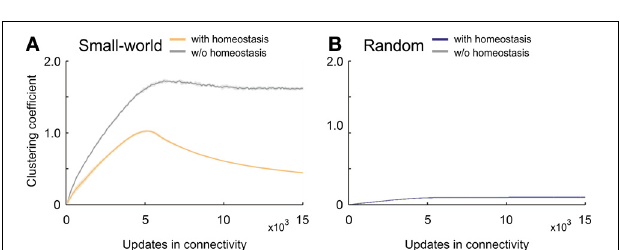
FIGURE 6 | Clustering coefficient in developing networks. (A) Small-world networks with (orange) and without (gray) homeostasis in electrical activity. (B) Random networks with (blue) and without (gray) homeostasis in electrical activity. Means over five simulations per scenario. Shadings of the curves indicate standard deviations.